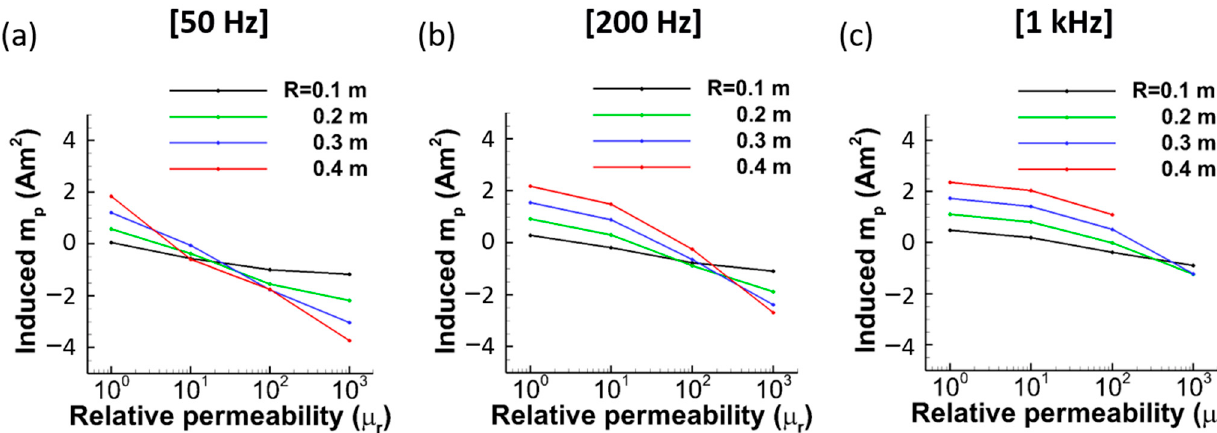
Figure 2. The amplitude ( m p ) of induced magnetic dipoles on sphere objects with various relative permeability at 50 Hz, 200 Hz, and 1 kHz. A radius of the sphere object is verified from 0.1 to 0.4 m.